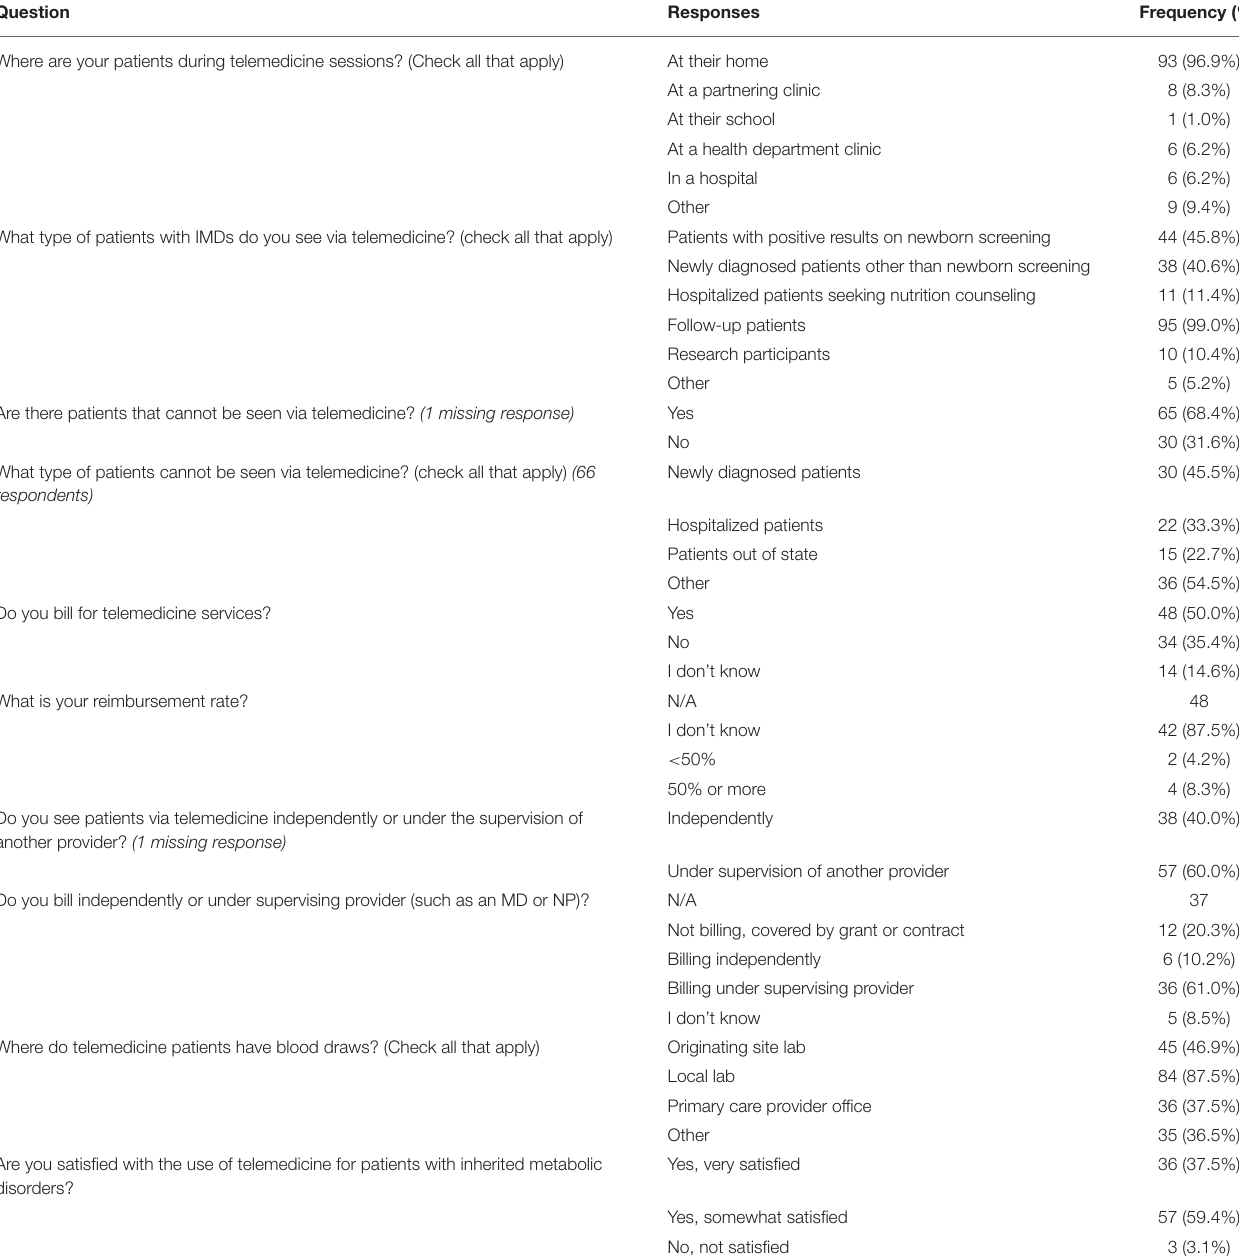
TABLE 2 | Responses by RDs who are currently using telemedicine to provide MNT to patients with IMDs ( n = 96). Question